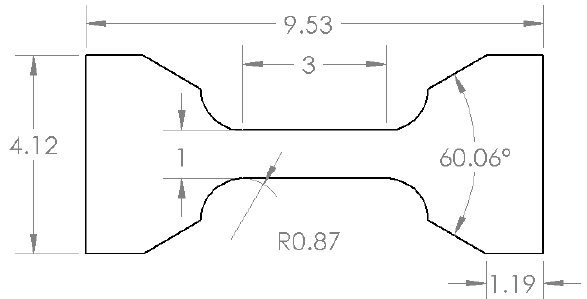
Figure 3. Dimensions of the miniature tensile test specimen; all of the dimensions are in mm.